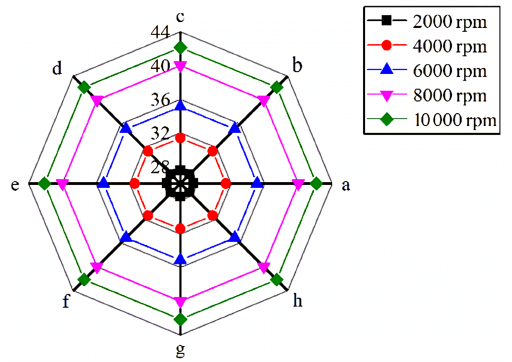
Figure 13. Circumferential steady-state temperature field distribu- tion of circle 1 at different rotating speeds.